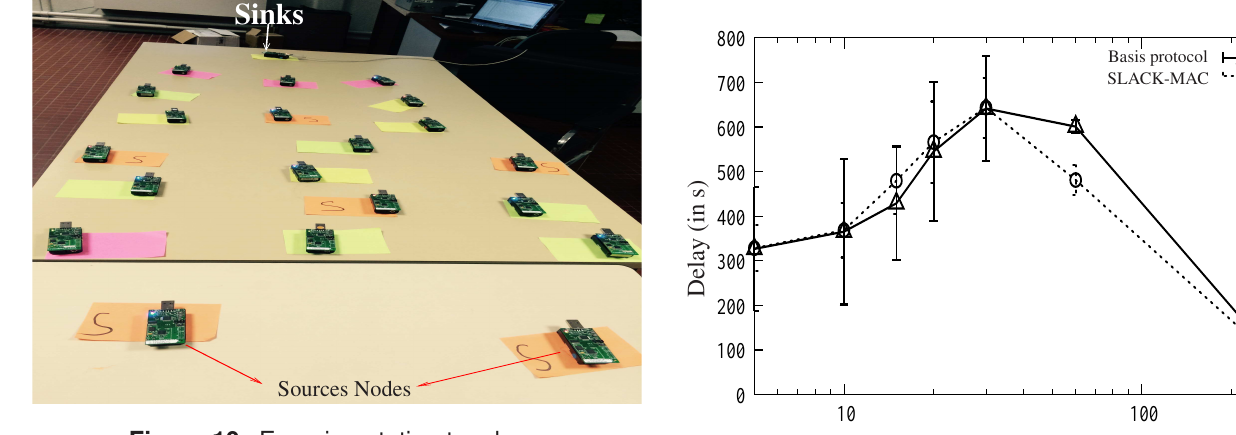
Figure 10. Experimentation topology.